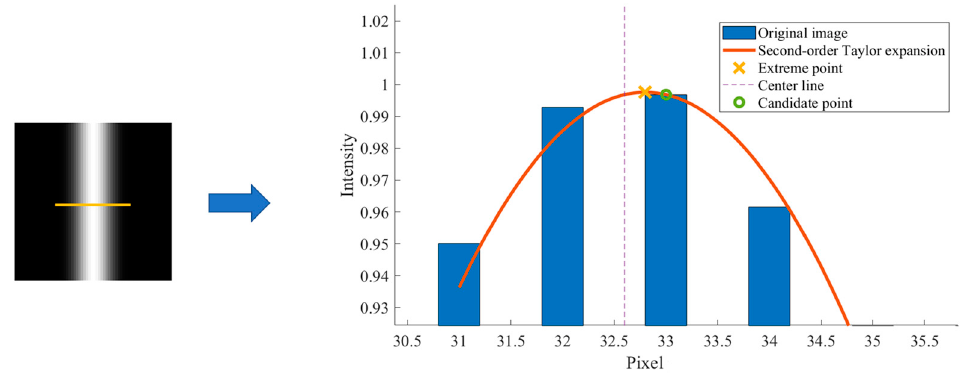
Figure 7. Intensity value in the direction of the normal vector of the interference ring.